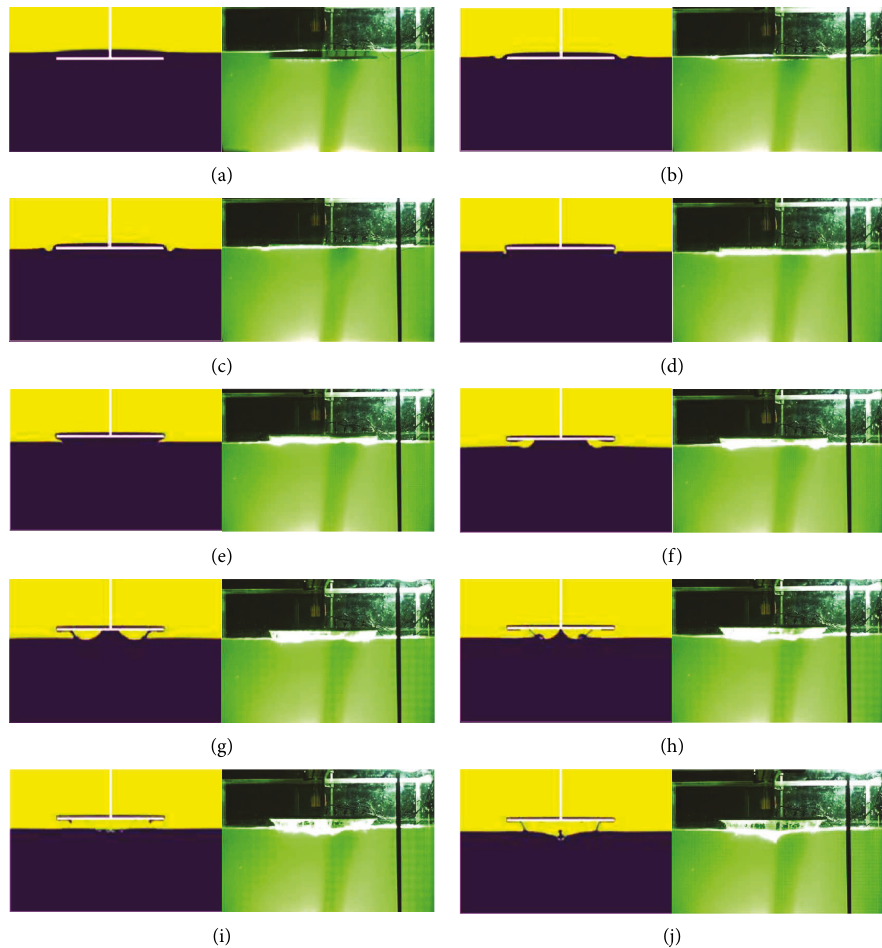
Figure 12: Comparison between the computed and experimental water-exit processes. (a) t � 5.28s. (b) t � 5.32s. (c) t � 5.35s. (d) t � 5.37s. (e) t � 5.39s. (f) t � 5.40s. (g) t � 5.41s. (h) t � 5.42s. (i) t � 5.43s. (j) t �